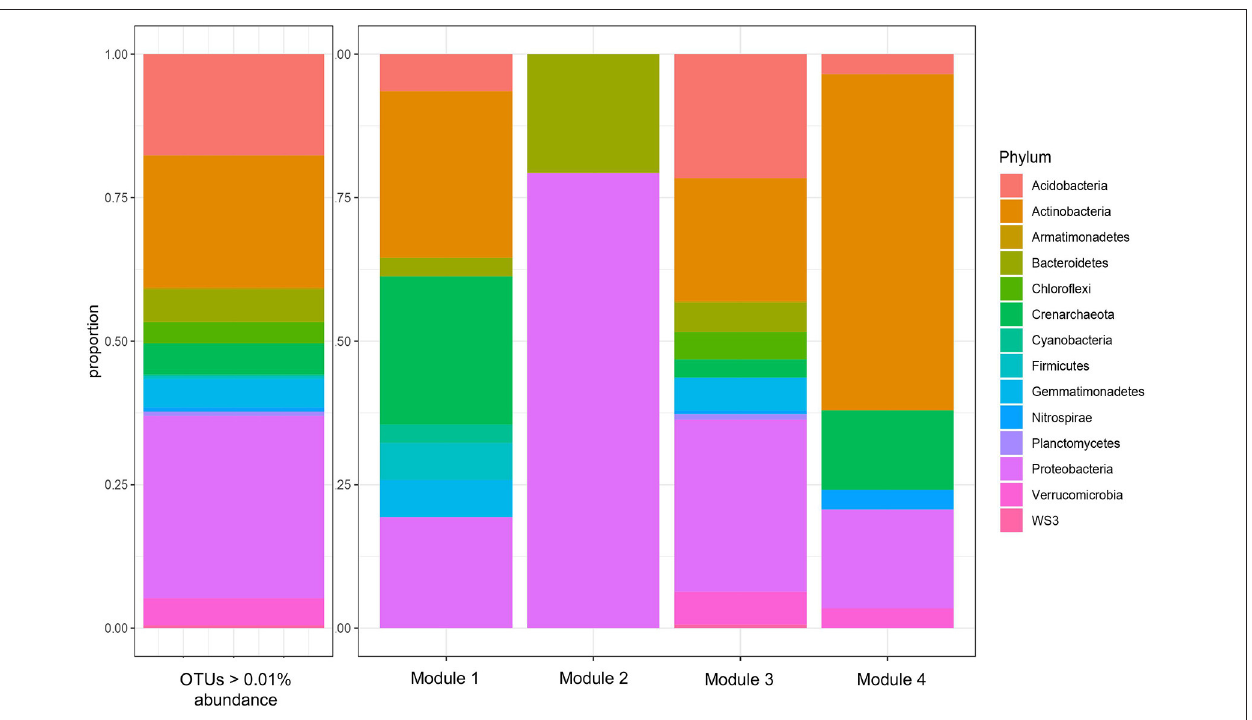
with that of the overall soil microbiome ( Figure 2 ).